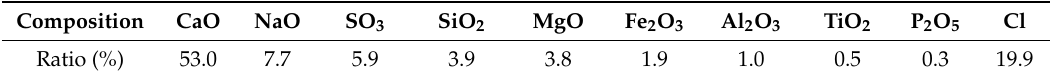
Figure 1. Particle size distribution of raw fly ash. Table 1. Basic compositions of raw fly ash.